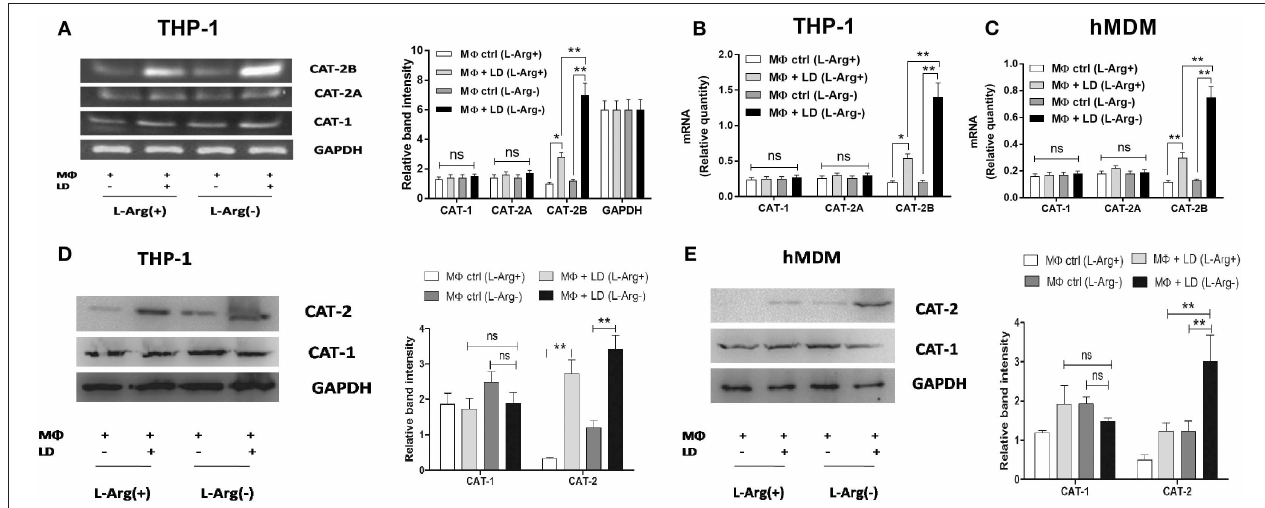
FIGURE 2 | Effect of Leishmania infection on expression of CAT-1 and CAT-2. THP-1 monocyte-derived M Φ s (A,B,D) and human monocyte-derived macrophages (hMDM) (C,E) (1 × 10 6 cells/ml) were grown in L -arginine-supplemented and L -arginine-depleted RPMI medium followed by infection with Leishmania donovani (multiplicity of infection 1:10) for 48h. The expression of CAT-1 and CAT-2 (CAT-2A and CAT-2B) were evaluated at the transcript level by semi-quantitative RT-PCR (A) and real-time PCR (B,C) and protein level by western blotting (D,E) . The intensity of the bands were quantified by densitometry in Quantity one software. Each experiment was repeated three times. Semi-QRT PCR gel images and western blots are representative of three experiments. Densitometric plots are shown adjacent to the gel images. Data are mean ± SD ( n = 3) ( * p < 0.05; ** p < 0.001; ns, non-significant) (Mann–Whitney U test).